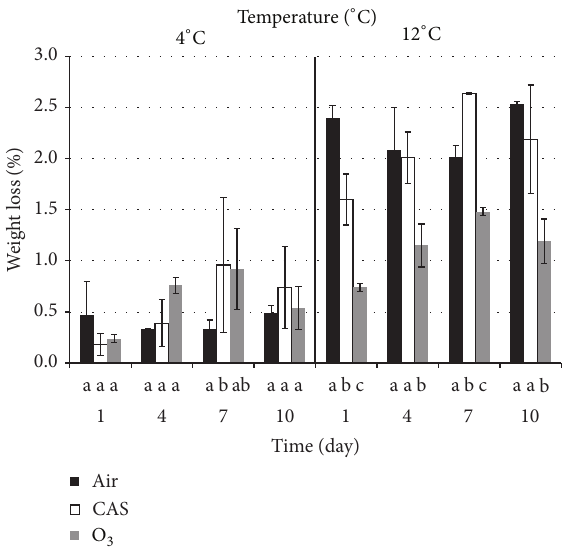
Figure 1: Weight loss percentage of highbush blueberries stored at 4 ∘ C or 12 ∘ C under controlled atmosphere storage conditions (CAS), ozone (O 3 ), or regular atmosphere (Air) during 10 days. Columns within each day at same temperature followed by the same lowercase letter are not significantly different (𝑃 > 0.05) from each